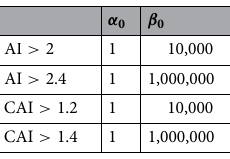
Table 3. Beta prior parameters for p for different wave ( AI ) and crest ( CAI ) height